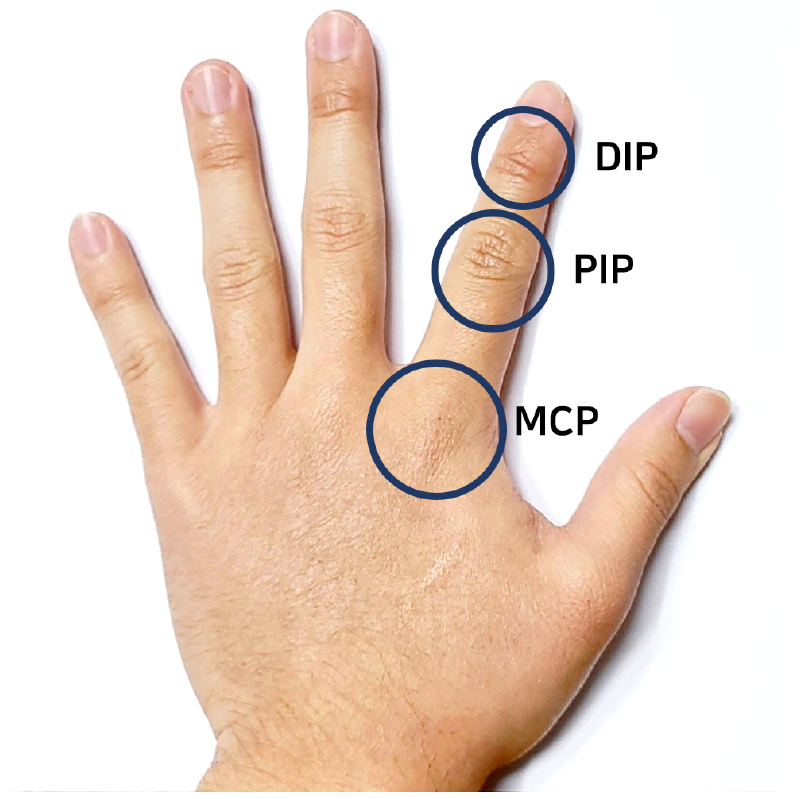
Figure 1. The basic hand anatomy of humans consists of MCP, PIP, and DIP joints. Apart from obtaining finger motion sensor data, the noise in the raw data must be reduced to minimize tracking errors. The least mean square (LMS) and weighted Fourier linear combiner (WFLC) algorithms, low-pass filter (LPF), and Kalman filter are candidate noise-reduction methods. The Kalman filter can be used to reduce the motion- tracking noise of a glove for VR applications [36,37]. The Kalman filter shows good compatibility with IMU sensors in terms of accuracy and noise reduction. However, this filter requires a relatively long processing time compared to the LPF [38] because